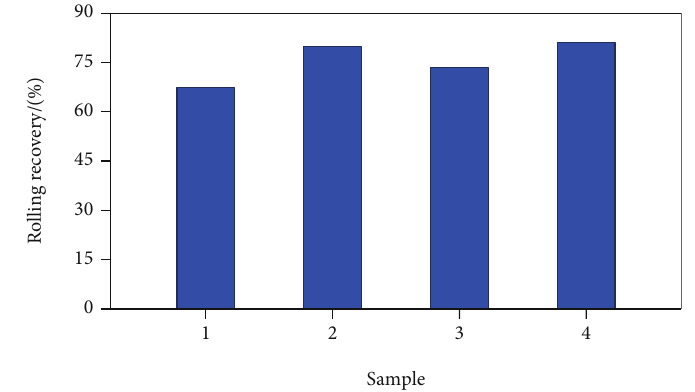
Figure 6: Shale dispersion in water testing